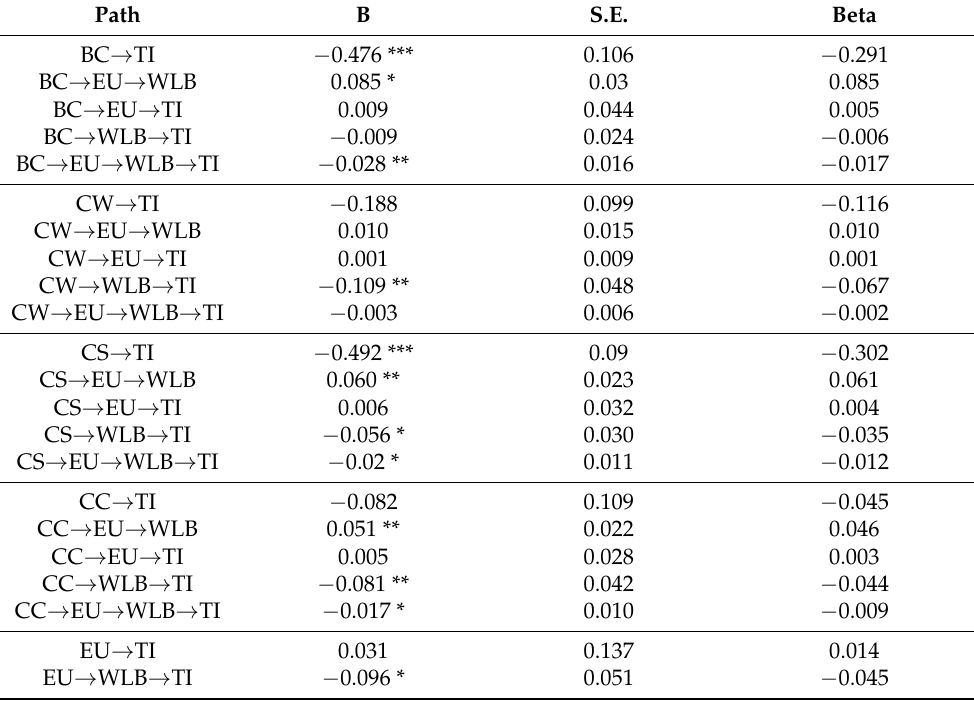
Table 5. Results of the mediation